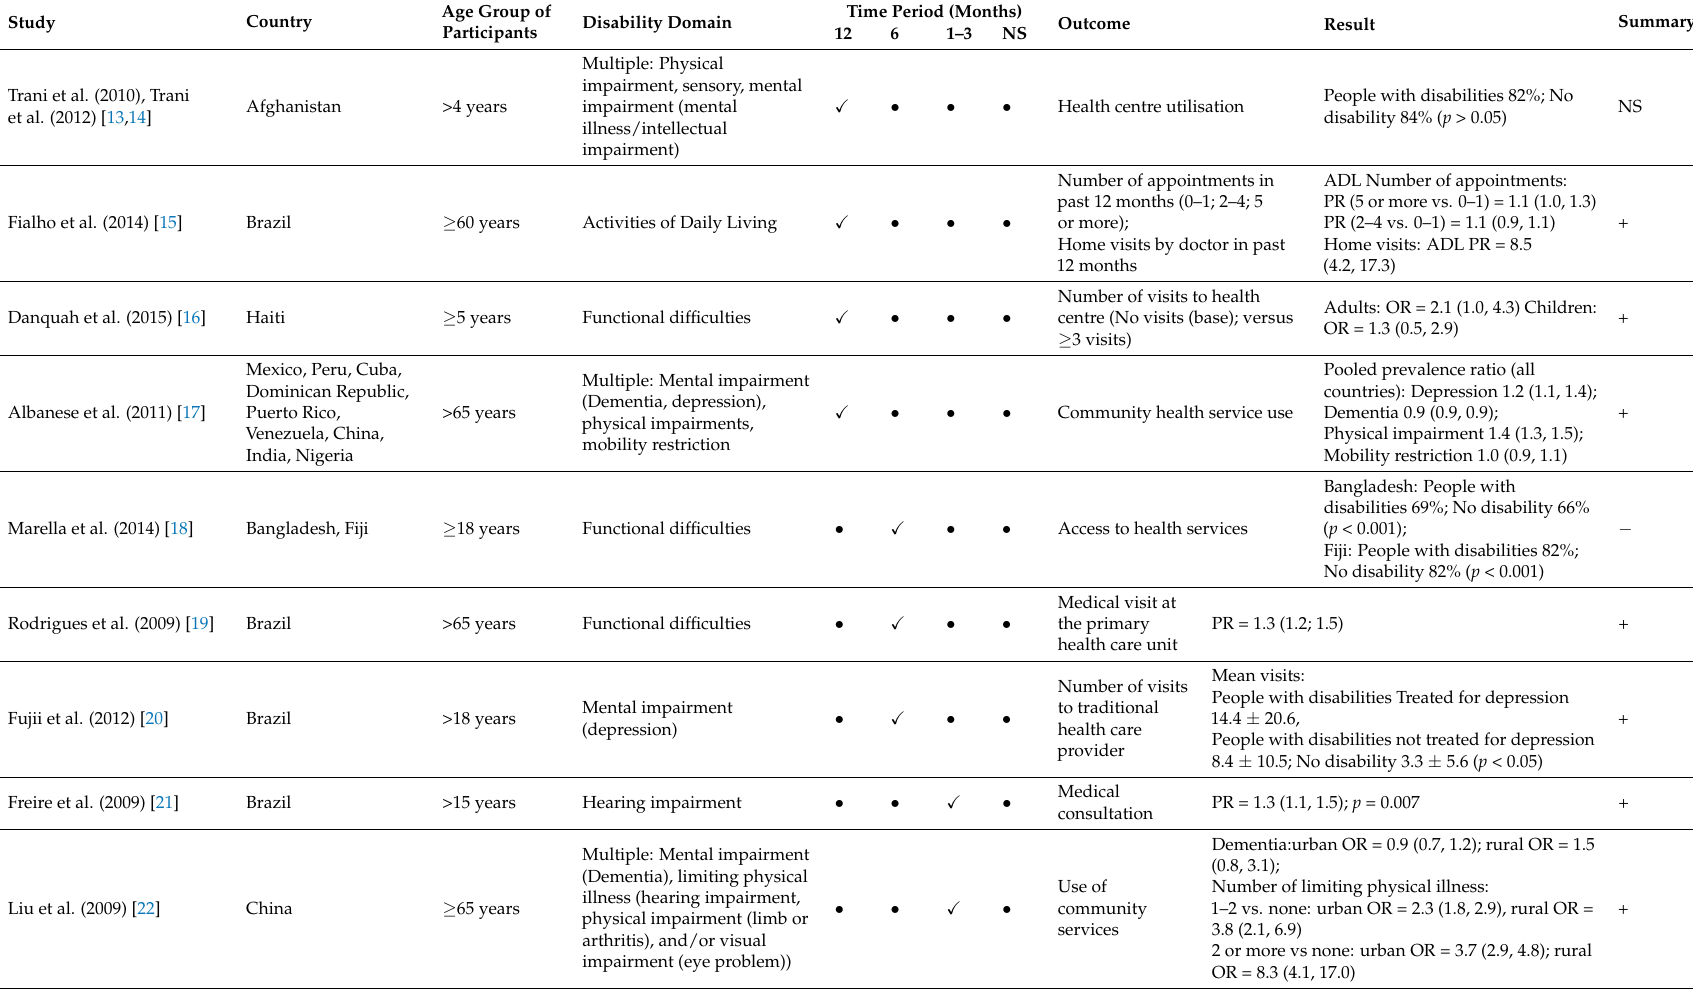
Table 3. Comparison of utilisation of primary health or secondary services between people with and without